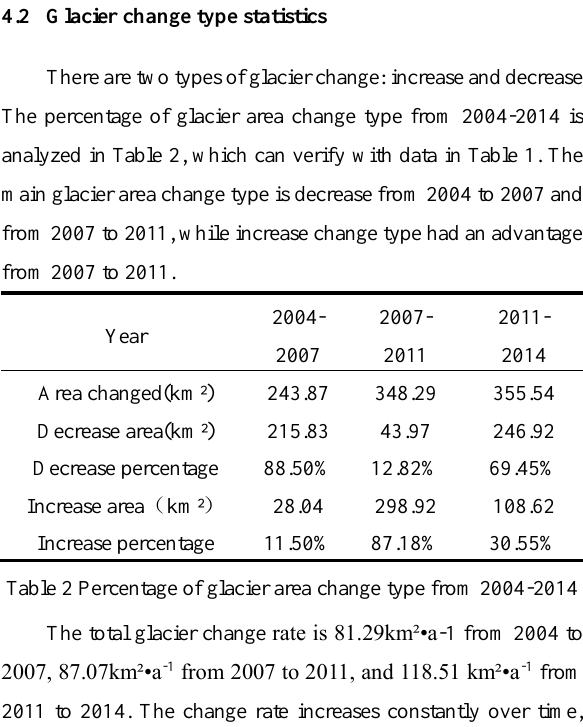
Figure 7 is generated combining glacier area and annual average temperature from 2004 to 2014.